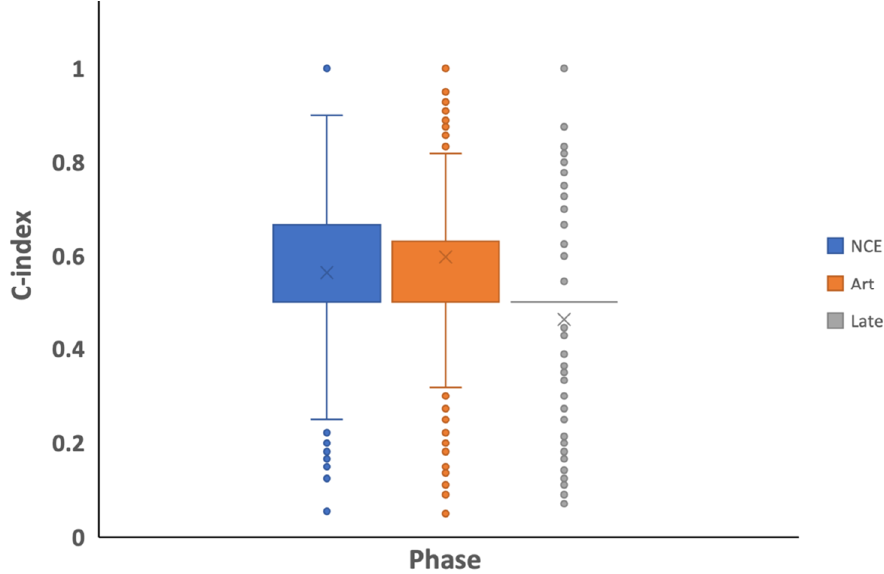
Figure 3. Boxplot comparison of the C-indices across the imaging phases.